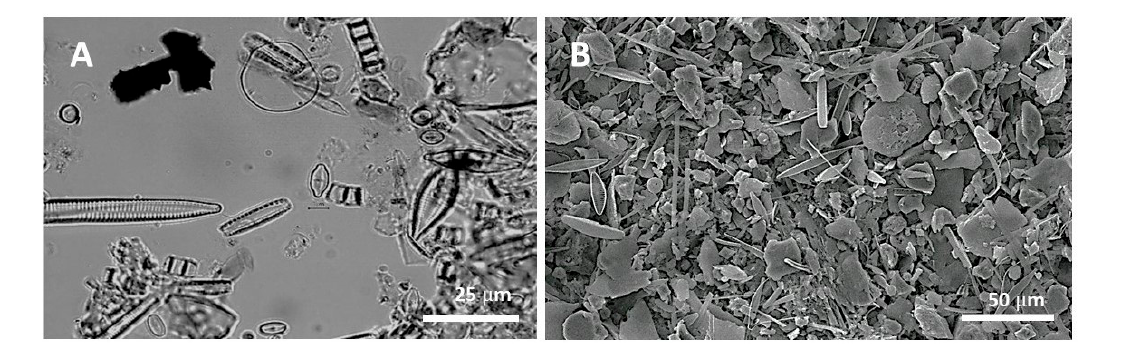
Figure 3. Light ( A ) and scanning electron microscopic photos ( B ) were prepared for the species identification and enumeration of epilithic diatoms collected from the sampling site.